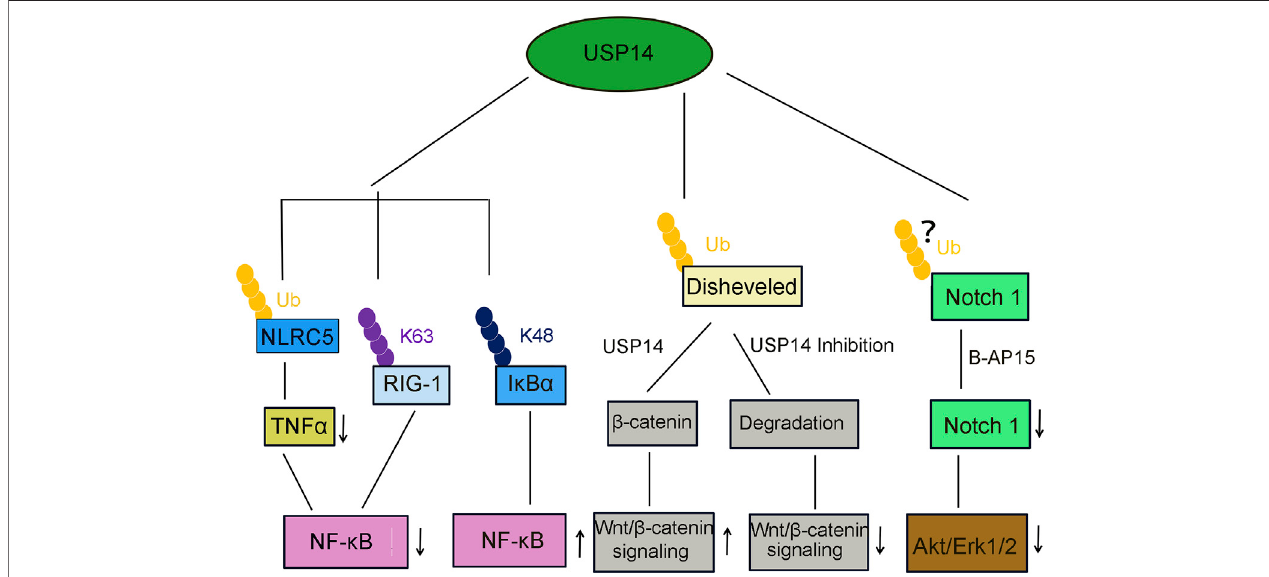
FIGURE 6 | USP14 is involved in several canonical signaling pathway. USP14 deubiquitinates NLRC5, then inhibits TNF α release and NF- κ B signaling activation. USP14deubiquitinatesK63-linked RIG-I and decreased theRIG-I-induced activation ofNF- κ Bsignaling. USP14deubiquitinatesK48-linkedI- κ B α and promote theNF- κ B signaling. USP14 deubiquitinates and stabilize β -catenin and then activated the Wnt/ β -catenin signaling pathway. In contrast, inhibition or knockdown of USP14 attenuated the Wnt/ β -catenin signaling. Treatment of USP14 with B-AP15 suppressed the Notch1 signaling and also inhibited the phosphorylation of Akt and